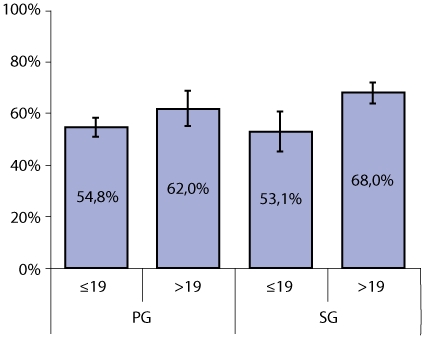
Proportion of women having received ≥2 doses of IPTp-SP during pregnancy by parity and age group.Error bars represent 95%confidence intervals. PG = primigravidae, SG = secundigravidae.